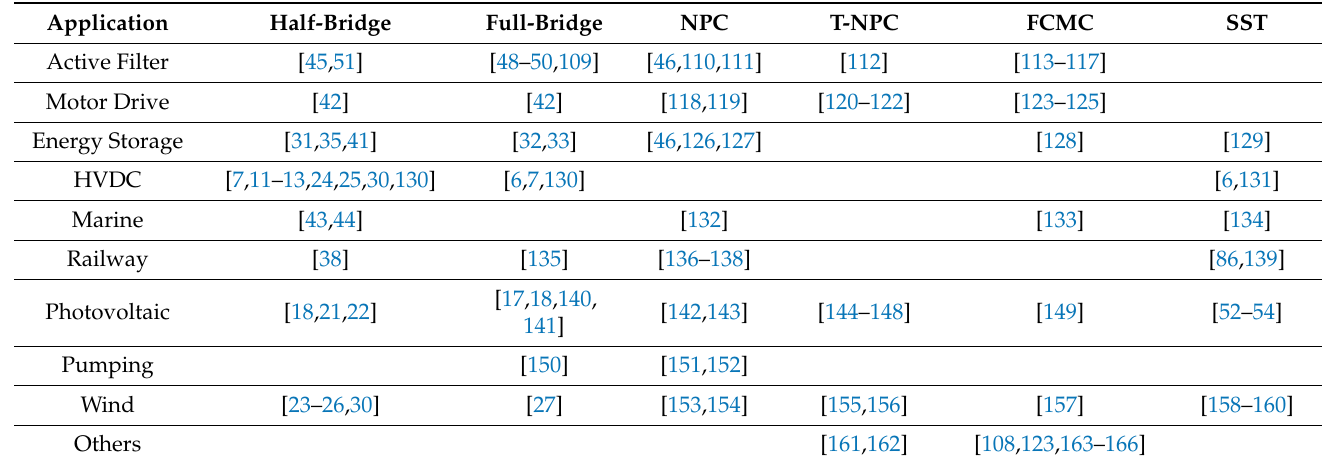
Table 2. Examples of MLC applications.